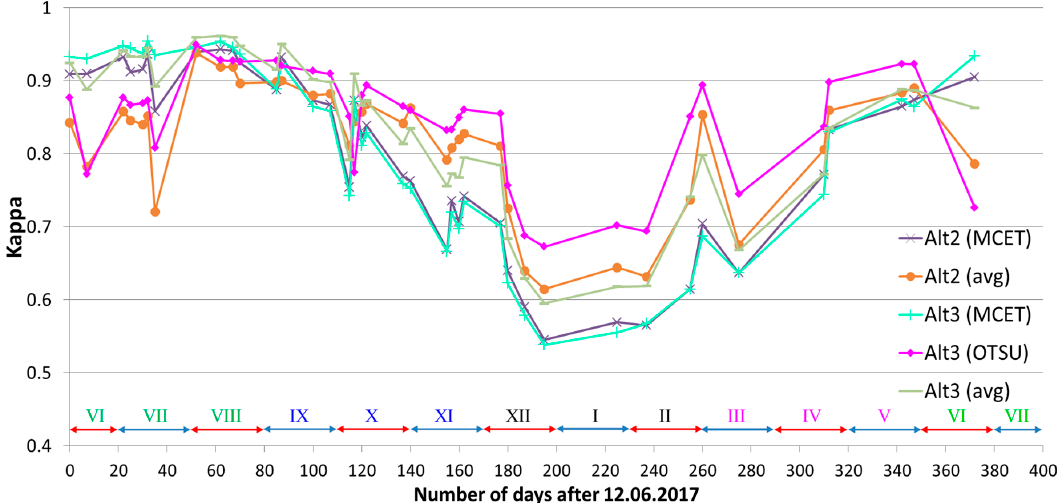
Figure 6. Kappa coefficient variation of five alternatives in the time period between 12 June, 2017 and 19 June, 2018. The months’ numbers are given as Latin numerals and are colored according to the season they belong, i.e., green for summer, blue for autumn, black for winter, and pink for spring.